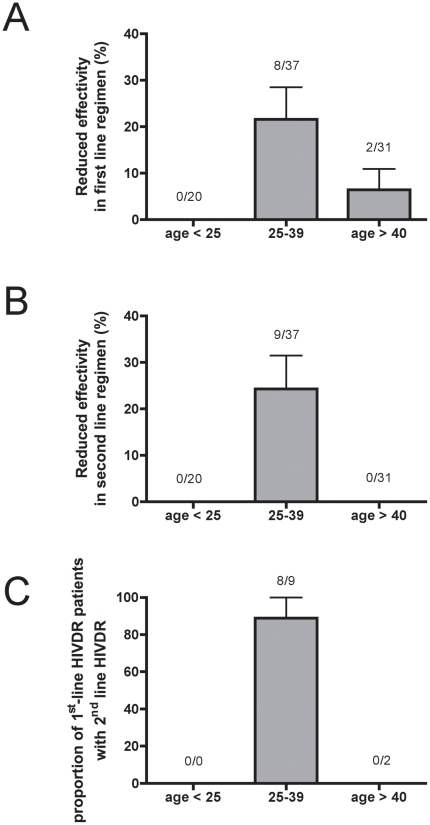
HIVDR affects efficacy of local first- and second-line ART regimens.Effects of HIVDR (high- and low-level resistances) on drugs included in the local antiretroviral regimens. A: Effects on local first-line ART regimen. HIVDR that affects at least one of the drugs included in first-line therapy (AZT/D4T plus 3TC plus NVP/EFV) scored positive. B: Effects on local second-line ART regimen. HIVDR that affects at least one of the drugs included in second-line therapy (ddI/ABC plus LPV/SQV plus RTV) scored positive. C: Proportion of patients with HIVDR that affects first-line ART regimen who also carry HIVDR that affects second-line ART regimen.